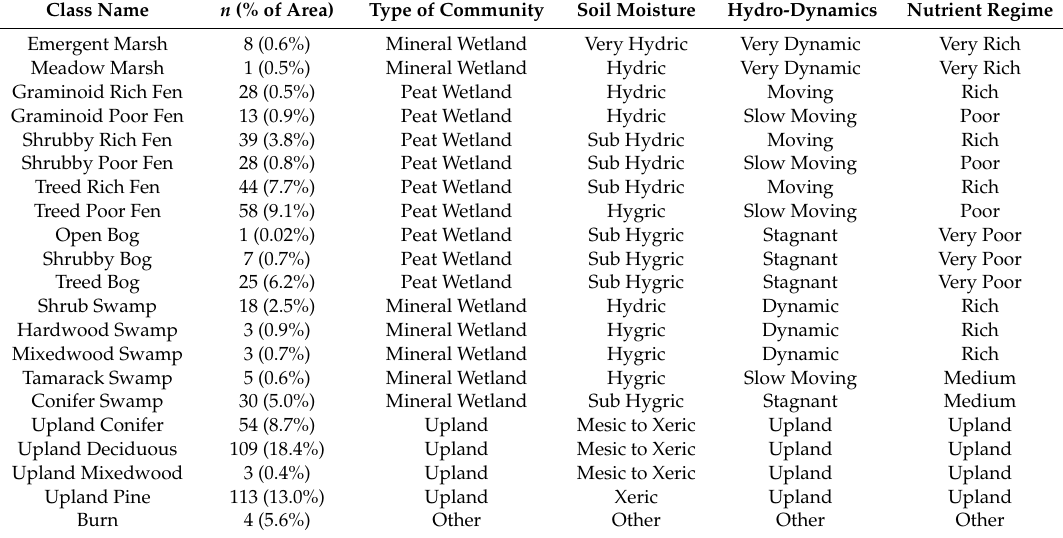
Figure 2. Example landscape variables used to predict locations of rare vascular plants (S1 or S2): ( a ) land cover (deciduous forest example; Ducks Unlimited Enhanced Wetland Classification (DU-EWC)); ( b ) terrain wetness from 50 m digital elevation model (DEM); ( c ) soil pH; and, ( d ) airborne light detection and ranging (LiDAR)-derived canopy height (95th percentile; note that gray areas of hillshade represent locations without LiDAR data). Table 1. Ducks Unlimited Enhanced Wetland Classification (DU-EWC) land cover types considered in models of rare plant habitat (occurrence) in the Lower Athabasca region of northeast Alberta, Canada (source: Ducks Unlimited). Note that some classes were combined in the analysis given their similarity and lower sample sizes. Number of plots ( n ) and percent coverage within study area by land cover class is